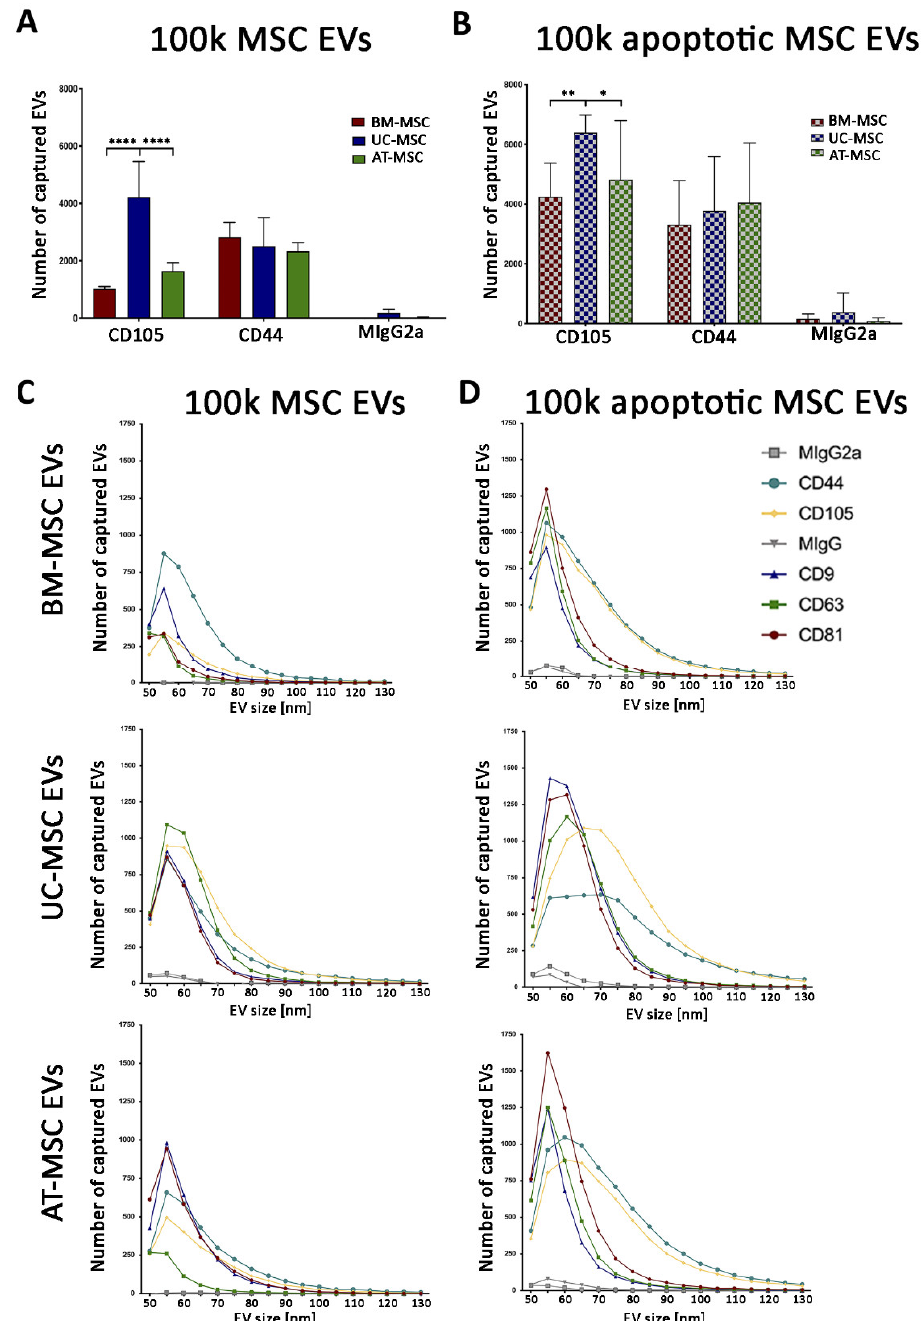
Figure 9. ExoView mesenchymal marker analysis of 100k of naive and apoptotic MSC EVs. ( A , B ) Histograms showing the number of captured EVs for mesenchymal markers (CD44, CD105) and negative control for 100k MSC EVs ( A ) and 100k apoptotic MSC EVs ( B ). Data are mean ± SD of three different experiments. A p value <0.05 was considered significant (* p < 0.05, ** p < 0.001, **** p < 0.0001). ( C , D ) Size of naive ( C ) and apoptotic ( D ) 100k MSC EVs from BM-MSC EVs, UC-MSC EVs and AT-MSC EVs.